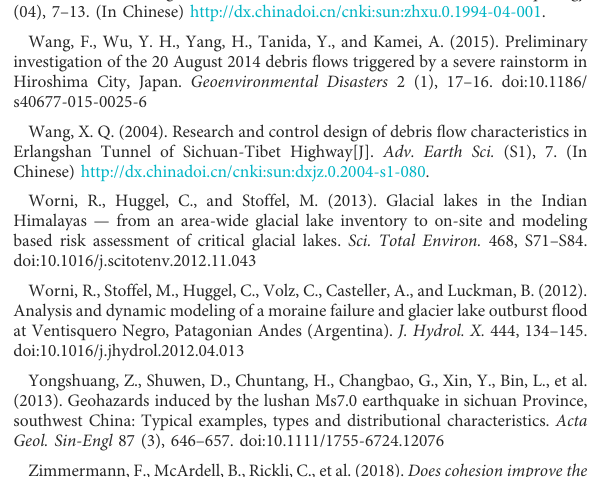
shaking table tests. Eng. Geol. 245, 153 – 168.